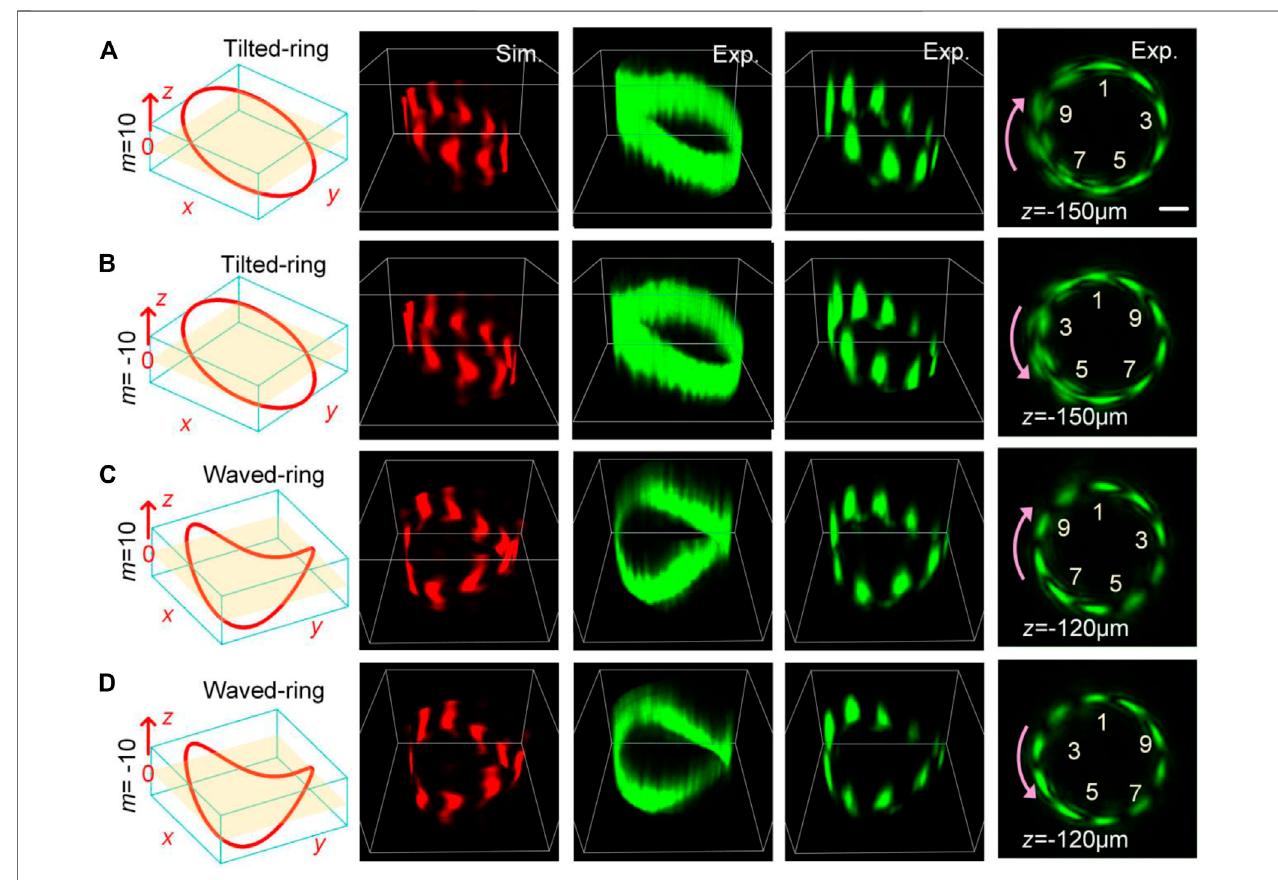
FIGURE4| DeterminationofPGPof3DPBs. (A,B) Tilted-ring with m =±10. (C,D) Waved-ringwith m =±10.Columns1and2arethenumericalsimulationresults of the 3D view of PBs and the interference intensity pro fi les. Columns 3 and 4 are the corresponding experimental results. Column 5 displays the beam propagated before the focal plane. Scale bar: 100 μ